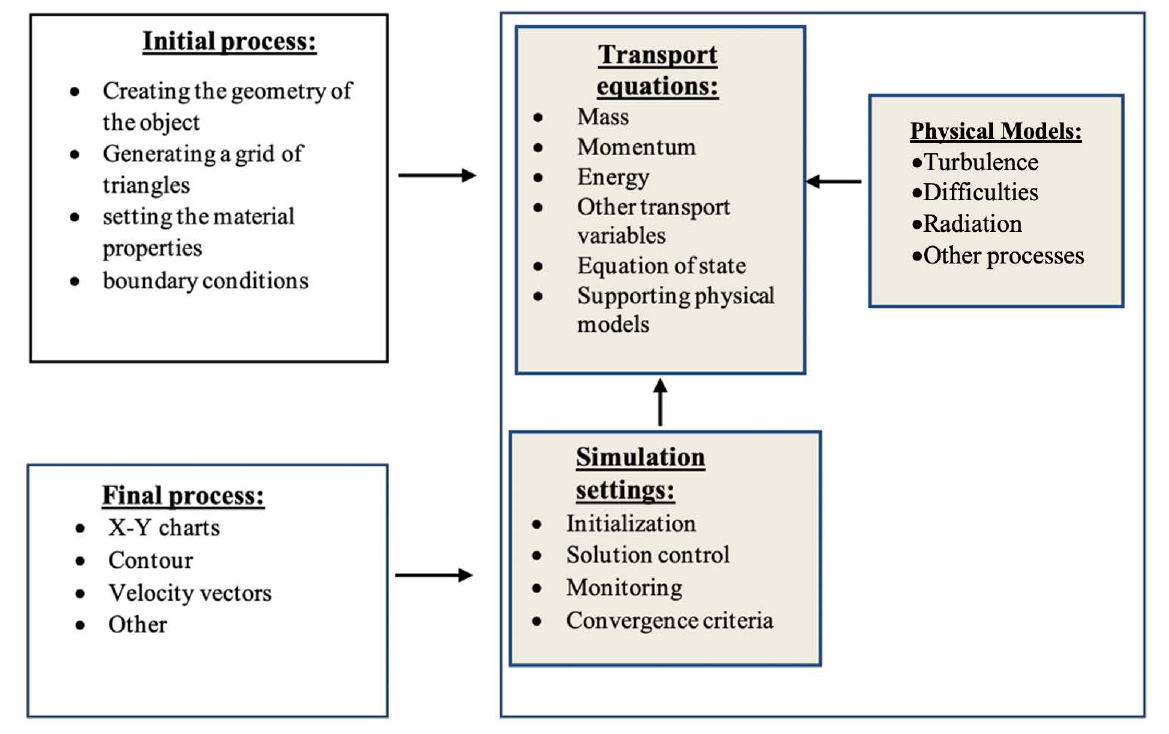
Figure 1. The simulation diagram in ANSYS